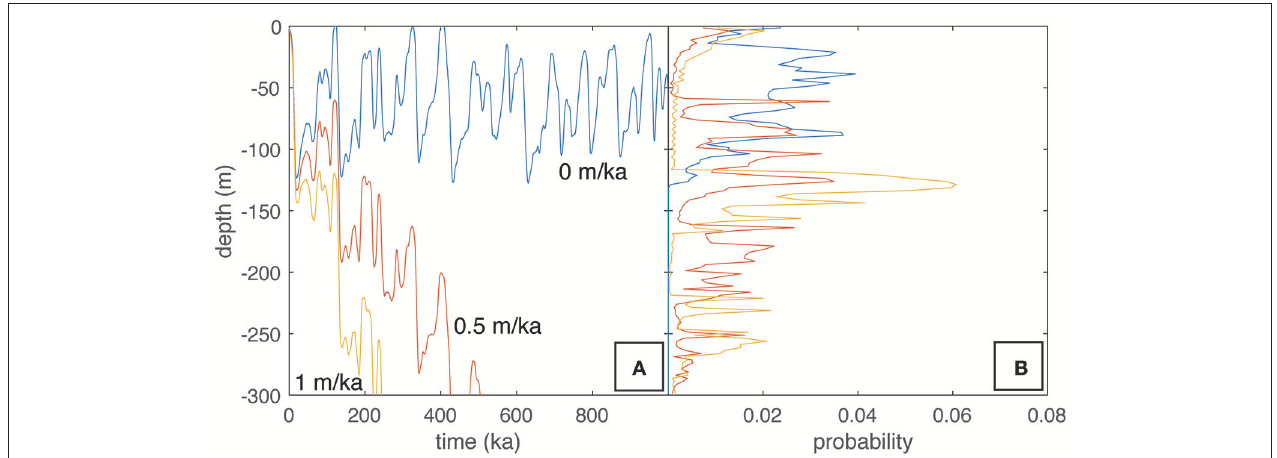
FIGURE 11 | Examples of subsidence normalized sea level depth integrations. (A) Sea level as a function of time for the past 1,000 ka. Blue curve shows sea level assuming no subsidence (Bintanja et al., 2005). Red curve shows the same sea level data adjusted for a subsidence rate of 0.5 m/ka, representing relative sea level change at this rate. Orange curve shows the same sea level data adjusted for a subsidence rate of 1 m/ka, representing relative sea level change at this rate. (B) Probability distributions representing the time integrated durations of sea level at all depths for each subsidence rate. Colors shown as defined in (A)